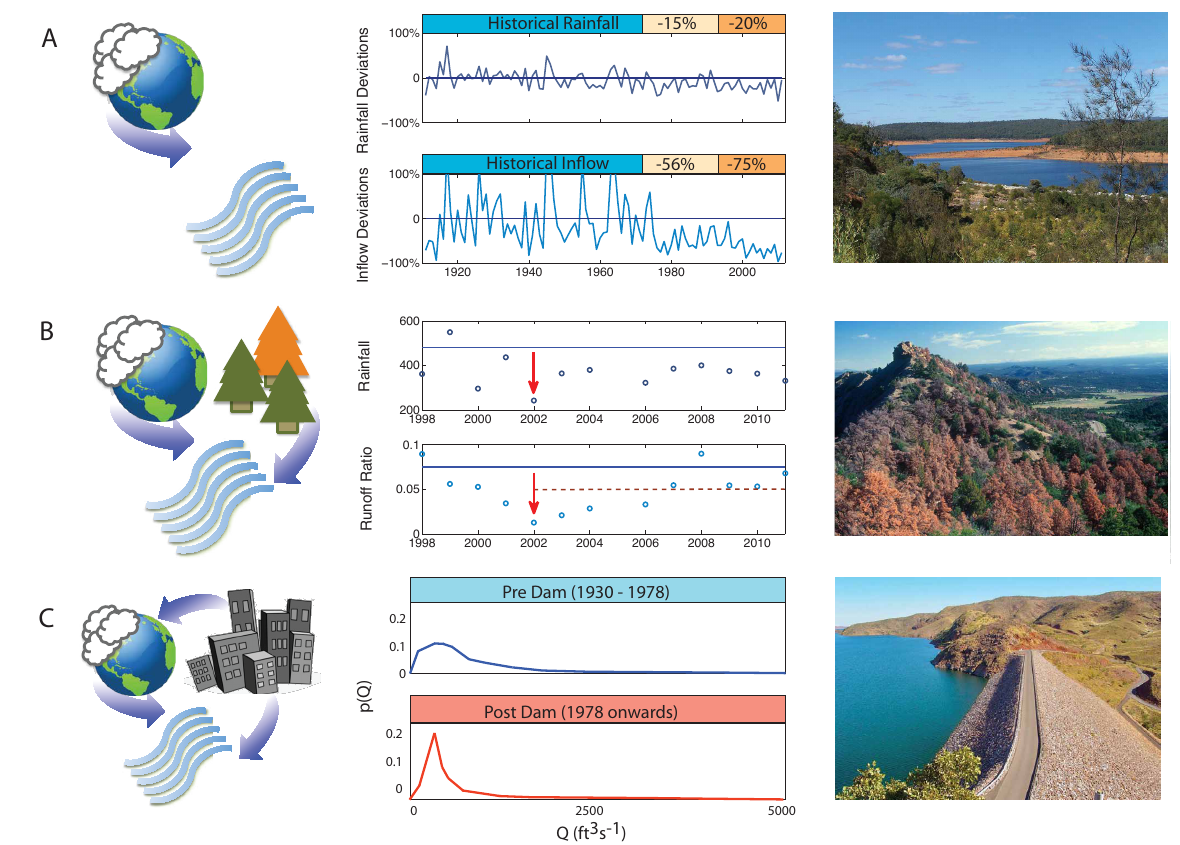
Fig. 1. Three fundamental challenges facing hydrological predictions in the Anthropocene. (A) Changing boundary conditions, illustrated by the 20% decline in annual rainfall in Western Australia, generate strongly non-linear responses in hydrological systems – in this case, a 75% decline in reservoir inflows, forcing water supply to transition from surface water resources to desalination and groundwater extrac- tion. (B) Propagation of changing boundary conditions into changes in interacting systems, illustrated here by Piñon pine mortality in the Southwest USA. Despite significant loss of forest cover and transpiring areas, runoff ratios in these regions remain at historically low levels, with 1969 the degree of runoff suppression proportional to forest mortality. (C) The potential for human action to generate large changes in hydrology in ways that hydrologists are not well equipped to predict. For instance, dam construction near the city of Raleigh, North Carolina has transformed the streamflow PDF in ways that could not be predicted from historical observation of the streamflow